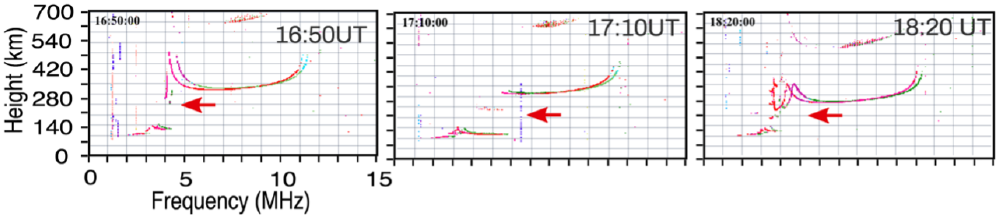
Figure 5. Ionograms collected at CXP at 16:50, 17:10, and 18:20UT, showing the F1 layer disappearance during the eclipse hours